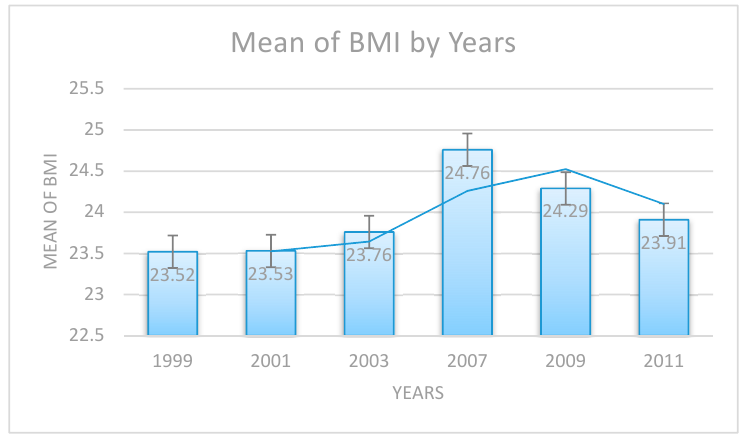
Figure 2. The age ‐ , sex ‐ , and ethnicity ‐ adjusted mean of the body mass index by years. Figure 2. The age-, sex-, and ethnicity-adjusted mean of the body mass index by Table 1. Description of the participants and their nutrition ‐ and physical activity ‐ related behaviors.